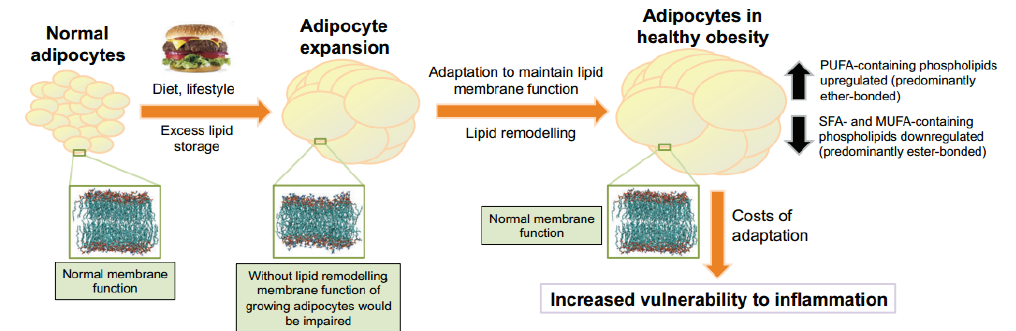
Figure 3 . Model of physiological regulation of lipid membrane in obesity *reference number 25